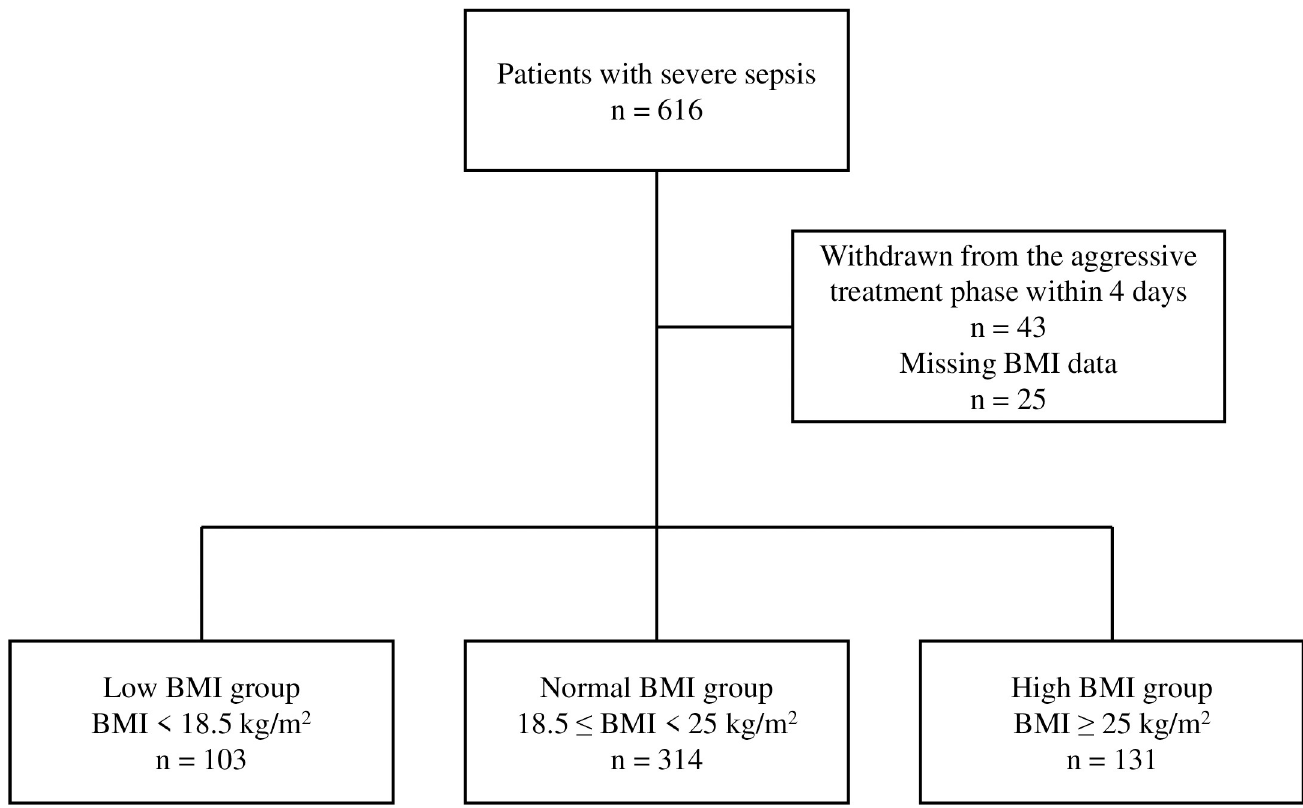
Fig 1. Flowchart of the patients enrolled in the Tohoku Sepsis Registry who were included in this study. BMI, body mass index.